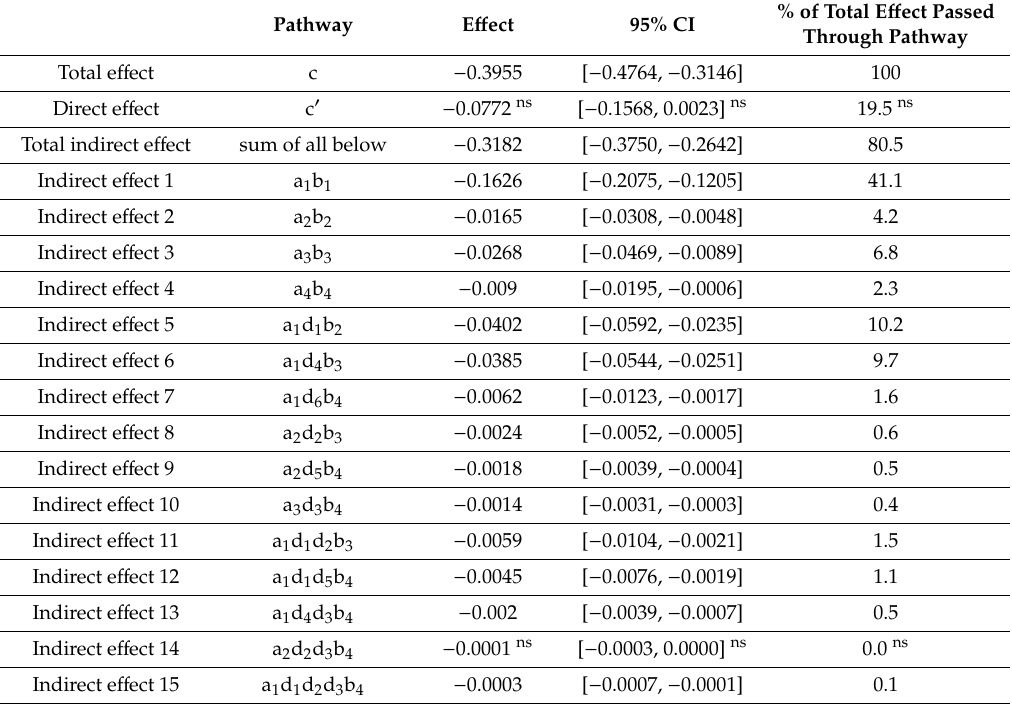
Table A2. Direct and indirect e ff ects for mediating pathways of the relationship between stress in 2012 and work ability in 2017 ( N =